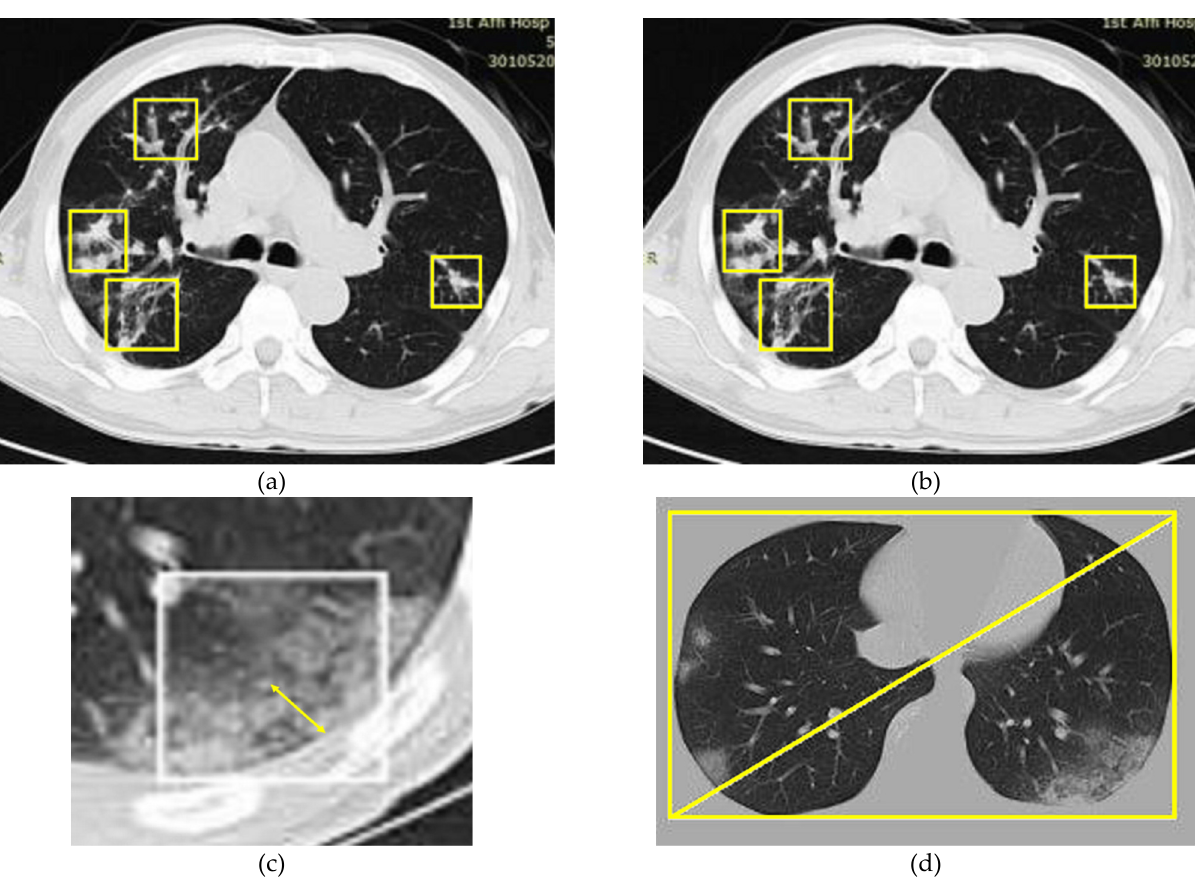
Figure 4. ( a ) Four ground-glass focus of infection on the novel coronavirus image; ( b ) similarly, the ground-glass image of influenza A viral pneumonia focused on infection; ( c ) identification of the distance (minimum) between the mask and the center of the patch (presented with a two-headed arrow); ( d ) diagonal identification of the bounded rectangle (with the minimum length) of the pulmonary image.